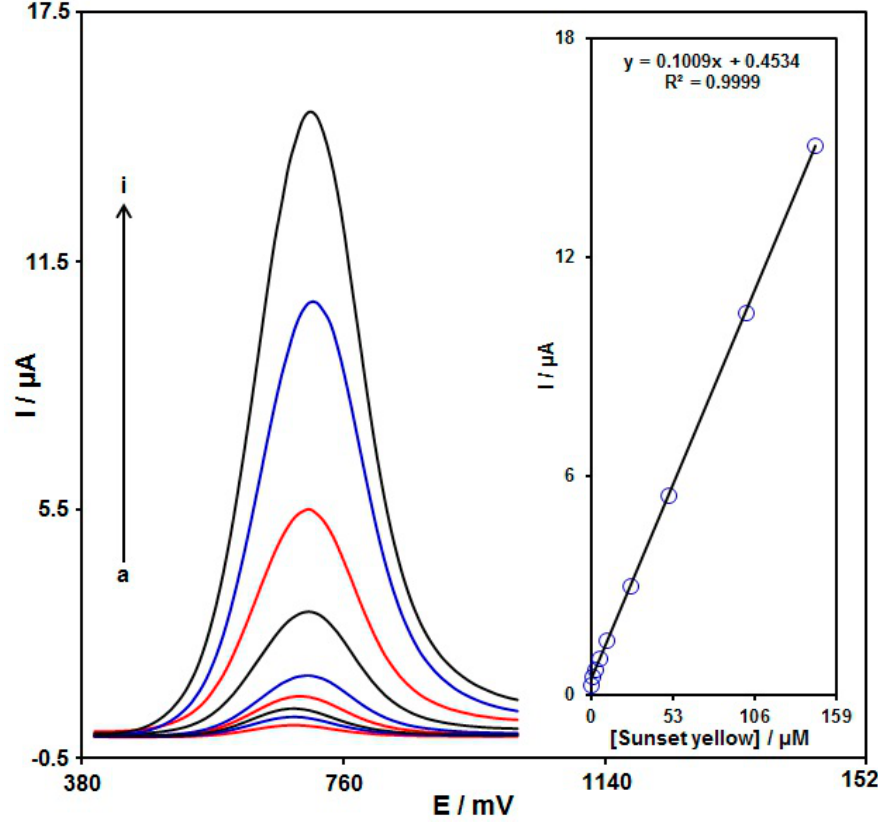
Figure 11. DPVs captured for the oxidation of variable sunset yellow contents on the NiCo 2 O 4 /SPGE (a: 0.02 µM, b: 0.2 µM, c: 2.0 µM, d: 5.0 µM, e: 10.0 µM, f: 25.0 µM, g: 50.0 µM, h: 100.0 µM, and i: 145.0 µM). Inset: Calibration curve of voltammetric response (Ipa) against sunset yellow level. Table 1. Comparison of the efficiency of the NiCo 2 O 4 /SPGE with other reported modified elec- trodes for sunset yellow determination.